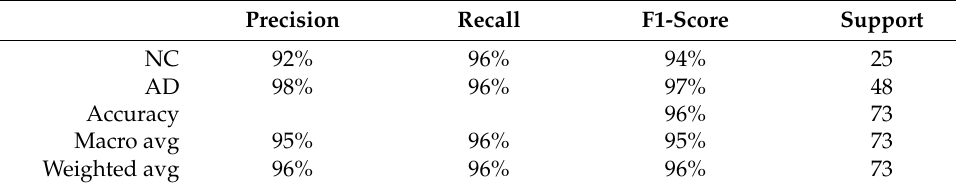
Table 5. Resnet50-Softmax experiment results with the MIRIAD